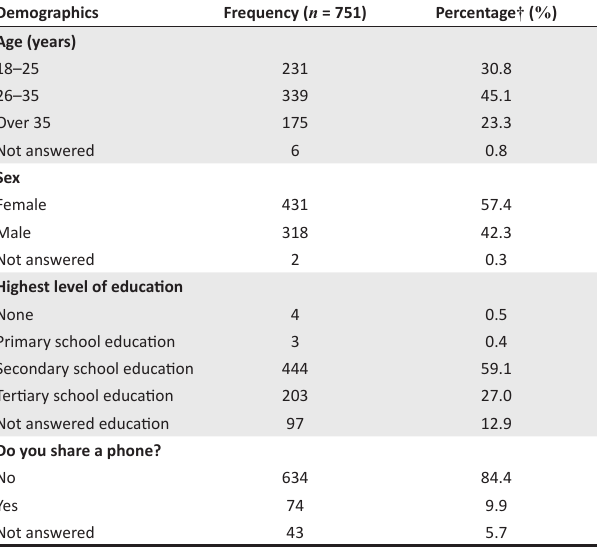
TABLE 1 : Demographic characteristics. TABLE 2 : Mean Likert scores for user experience.